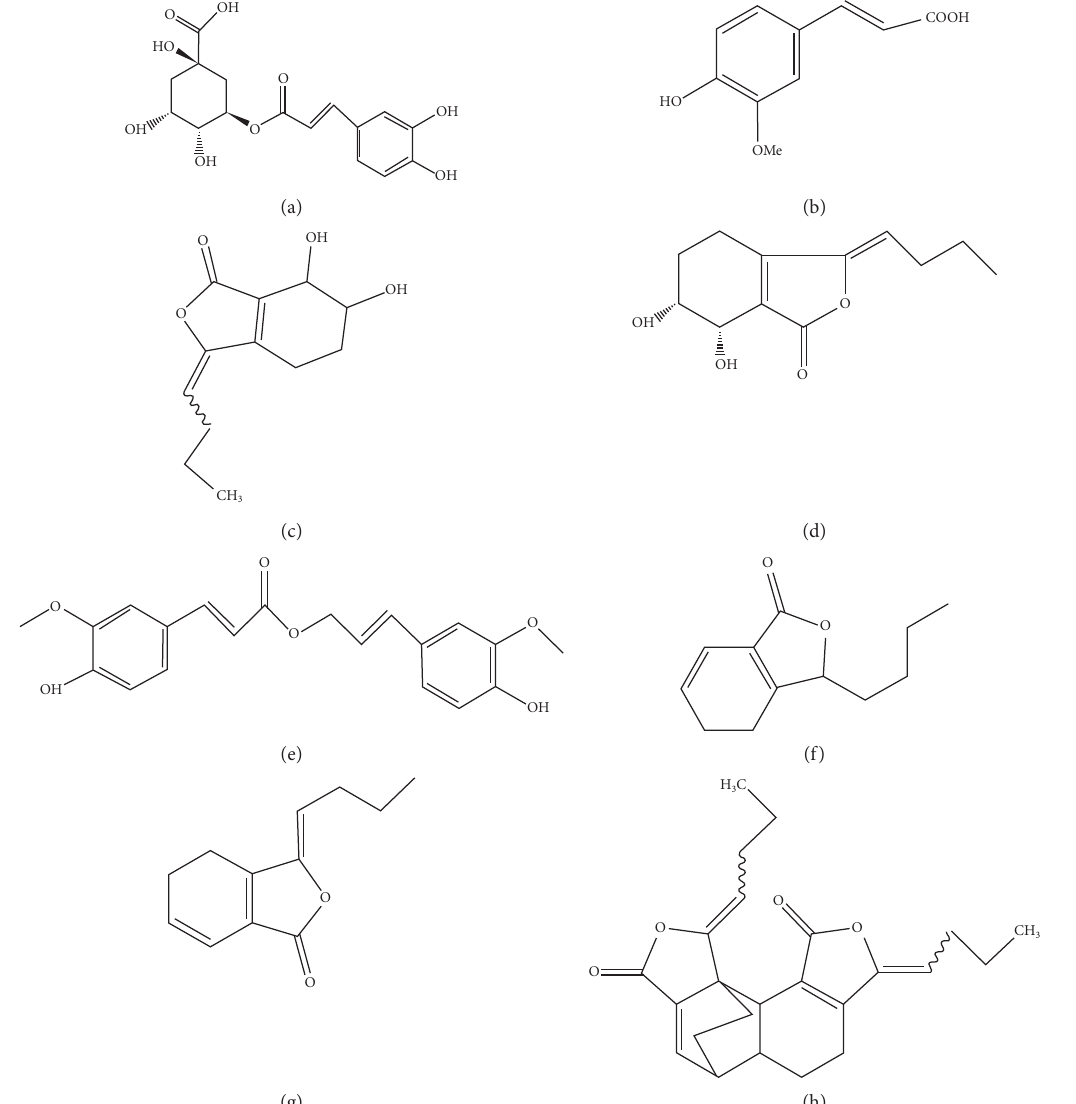
Figure 1: Chemical structures of chlorogenic acid (a), ferulic acid (b), senkyunolide I (c), senkyunolide H (d), coniferyl ferulate (e), senkyunolide A (f), ligustilide (g), and levistolide A